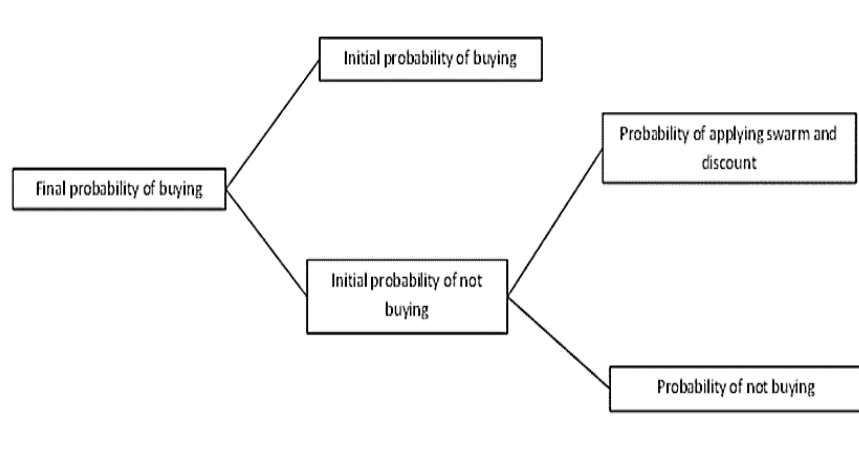
Fig. 3. Probability of buying [33].